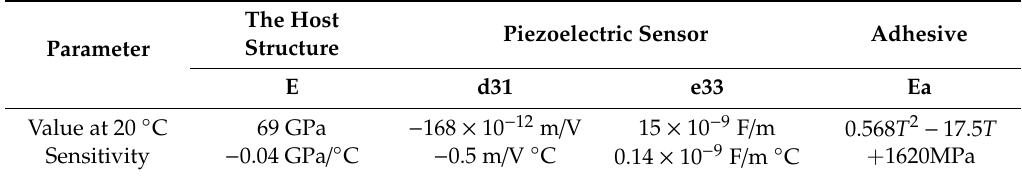
Table 1. Temperature-dependent parameters in